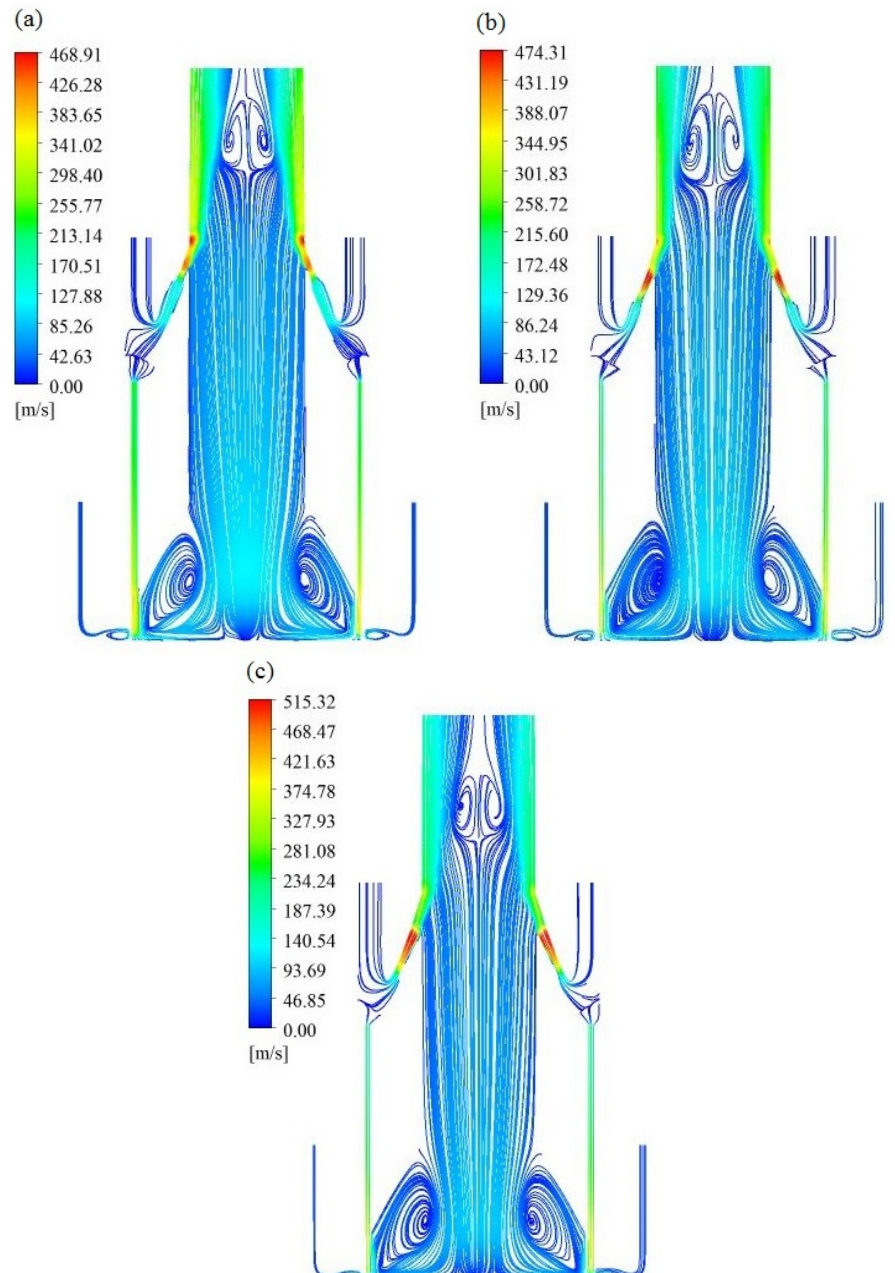
Figure 7. Visualization of the streamlines inside the reverse-circulation bit: ( a ) L s = 13 mm; ( b ) L s = 25 mm; and ( c ) L s = 37 mm.